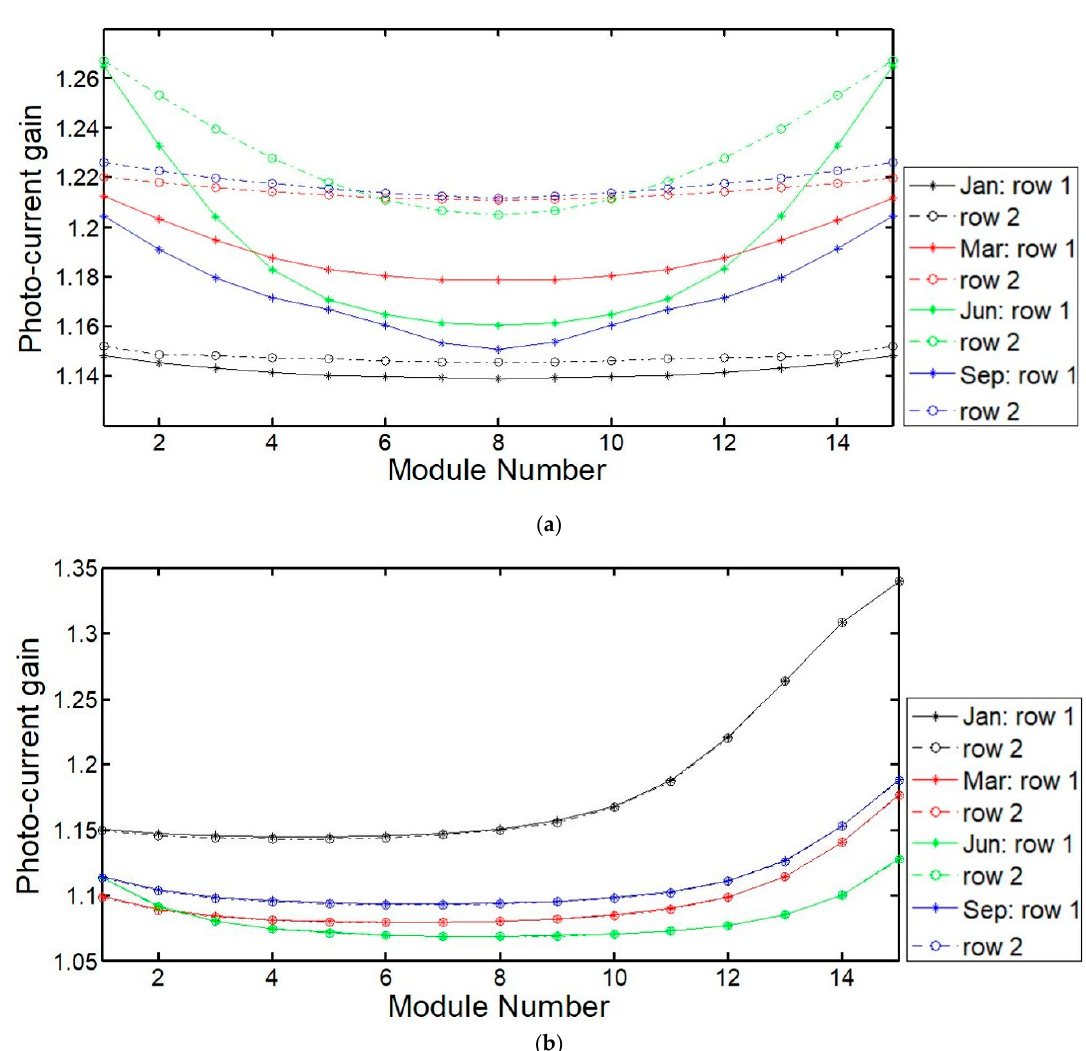
Figure 8. Photo-current gain average values of the 30 modules forming the fixed PV string (see graph in ( a )) and the PV string with uniaxial horizontal solar tracker (see graph in ( b )). For each PV module, the mentioned photo-current gain was computed by the model as the ratio (I sc,back + I sc,front ) / I sc,front (see the main text for the symbol meaning). The calculation was performed for the case of side size equal to 10 m (i.e., the saturation condition for the perimeter effects, according to the results shown in Figure 6,7), considering the Catania (Italy) latitude, for different hours of four days of 2018 (January 15th, March 20th, June 15th, and September 15th, i.e., the same days considered to obtain the graphs of Figure 7). For each of such days and for each PV module, the average value of the above defined hourly photo-current gains was determined, as plotted within the graphs here shown.